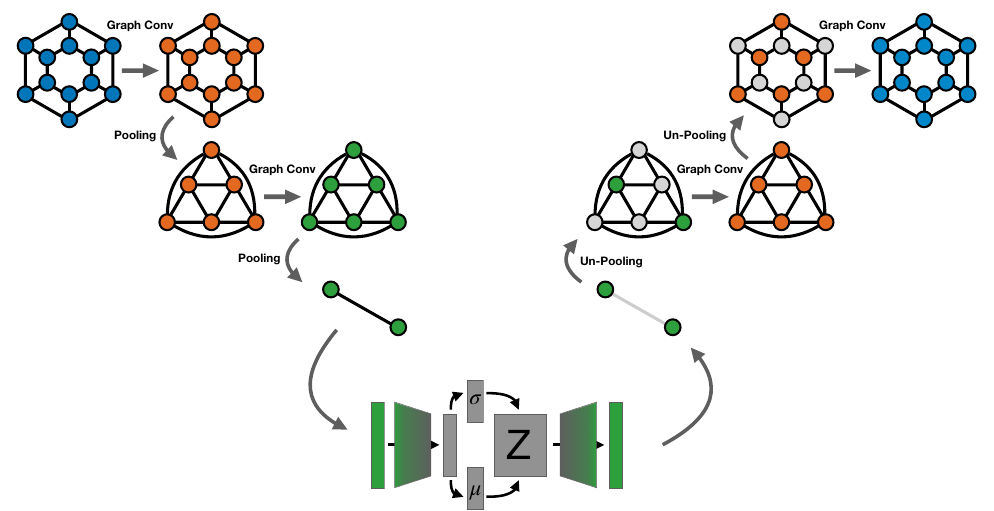
Figure 3. Full scheme. Schematic representation of our Re-NN Graph VAE with two encoding blocks and two decoding blocks. Each block is made up of a graph convolution and a pooling (un-pooling) operation. In the lower part of the picture, the VAE sampling and the encoding (decoding) linear layers are